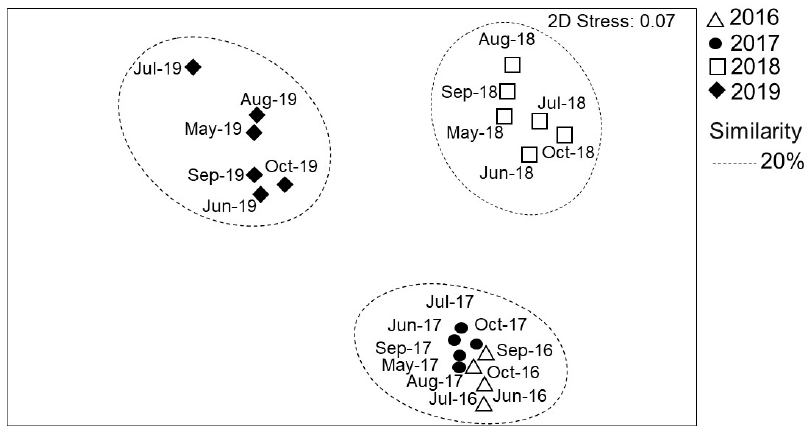
Figure 7. Non-metric multidimensional scaling ordination plots for retained catches in the months of different years.